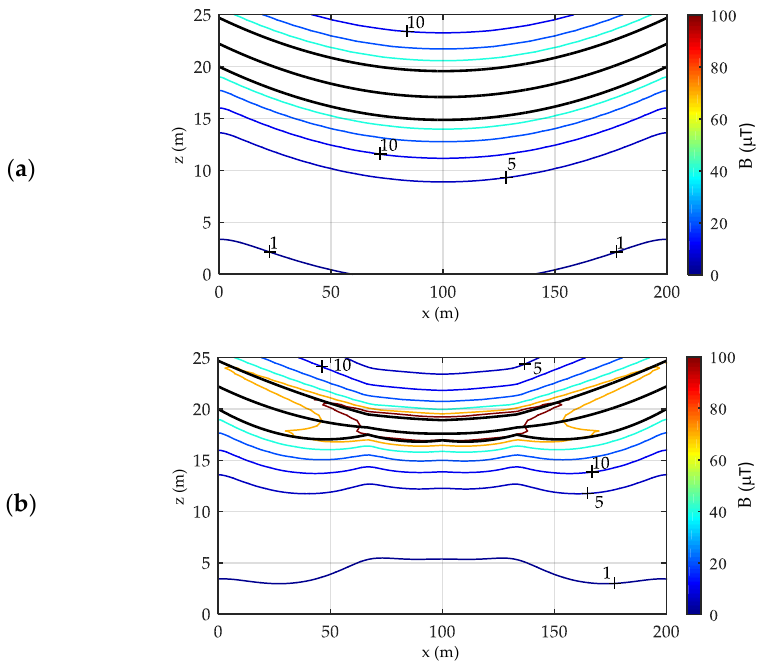
Figure 6. Distribution of the magnetic induction B on the transversal section orthogonally crossing the line in the span center, without compactors ( left ) and with three compactors ( right ). Energies 2017 , 10 , x FOR PEER REVIEW